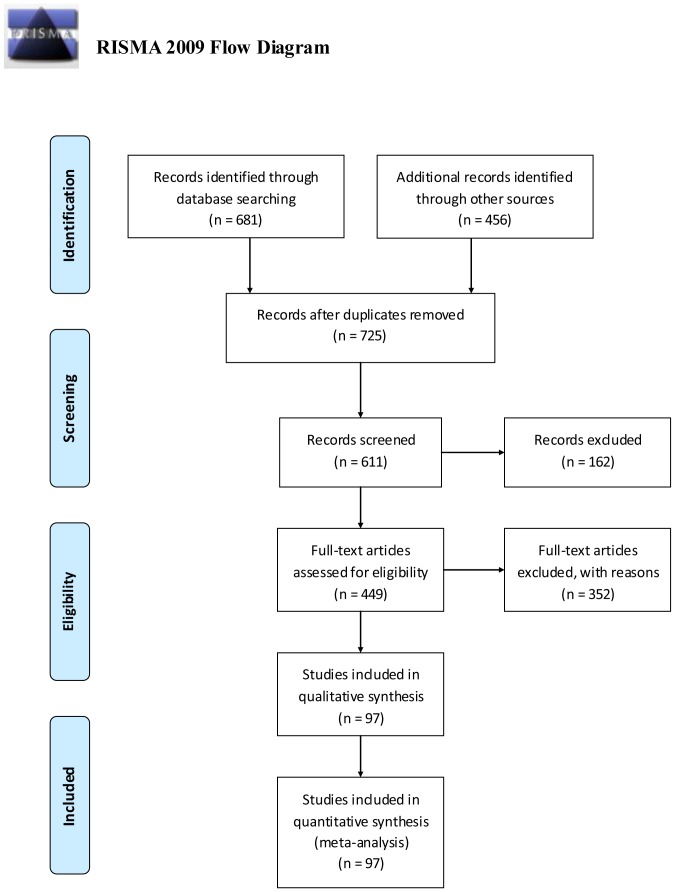
The flow diagram.